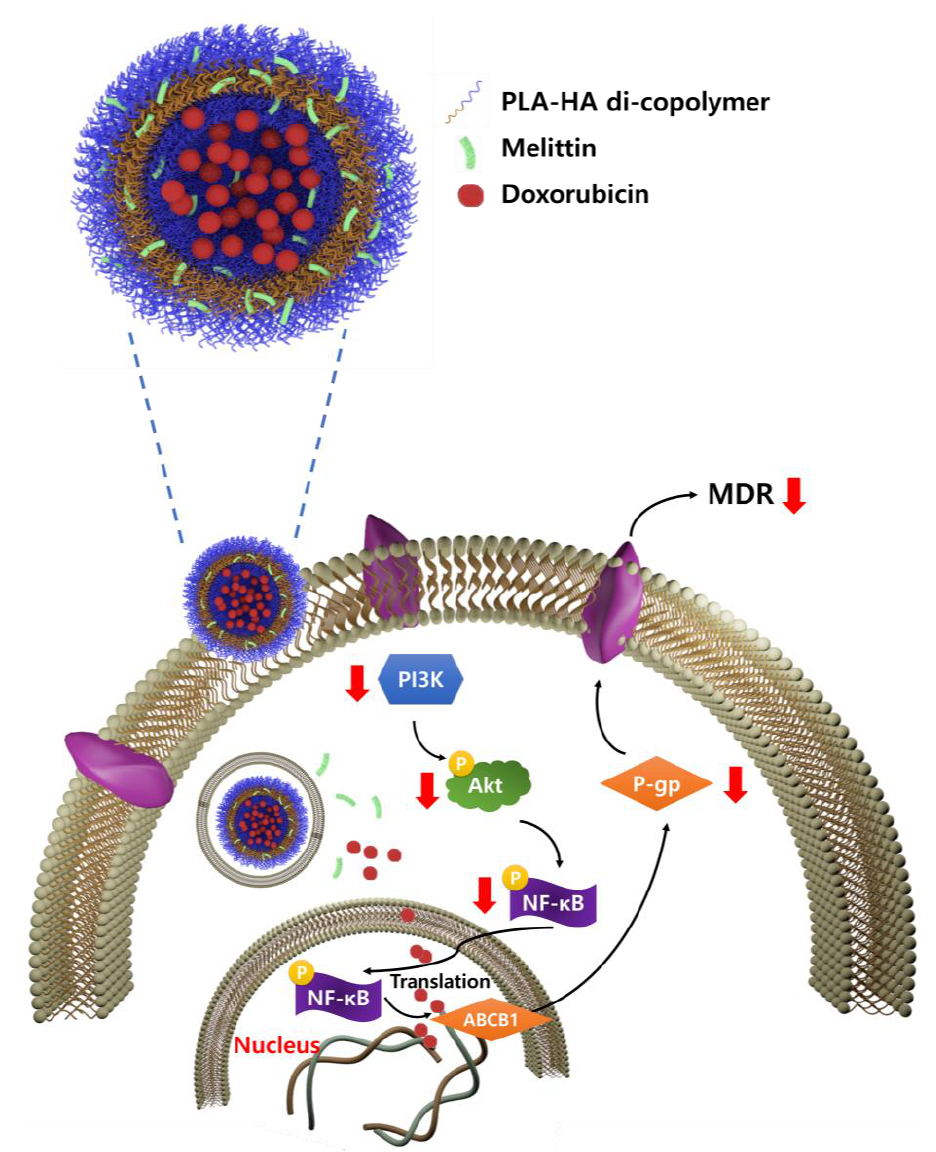
Figure 1. Schematic of Dox-Mel PL demonstrating the co-delivery of melittin and doxorubicin via a PLA-HA polymersome to downregulate PI3K/Akt and NF- κB pathways, consequently overcoming multidrug resistance and enhancing chemotherapeutic efficacy.